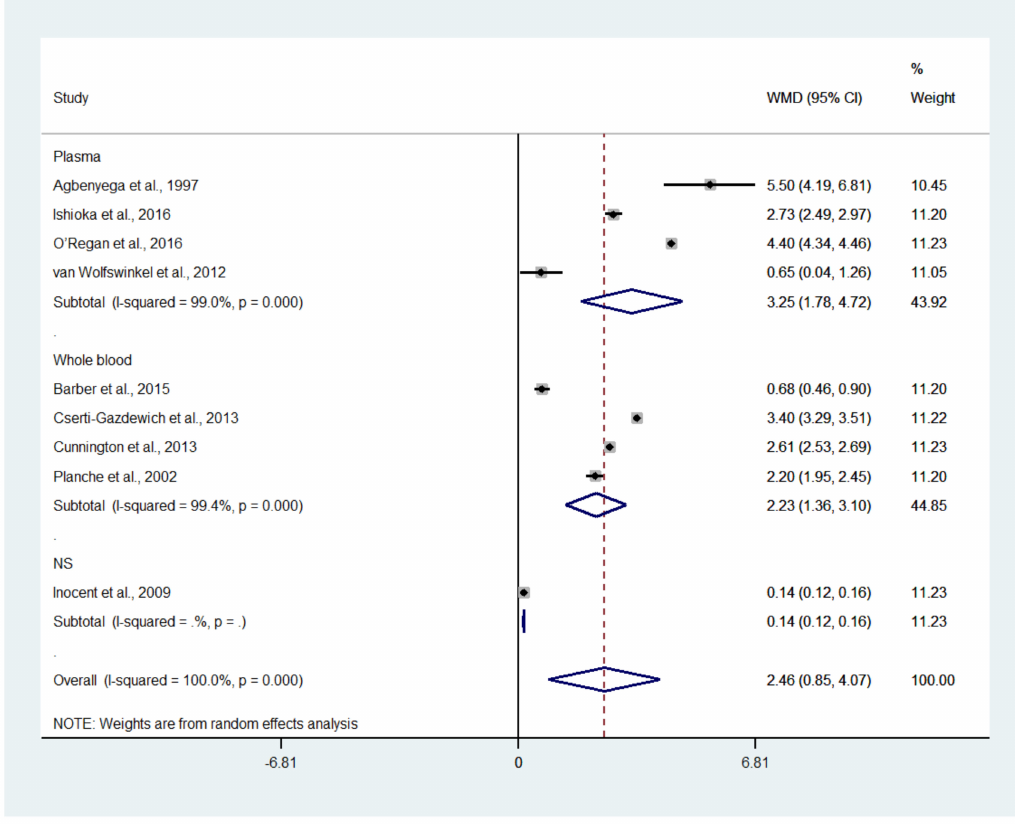
Figure 7. The difference in mean lactate level between patients with severe and uncomplicated malaria according to the different types of blood samples. Abbreviations: WMD, weighted mean difference; CI, confidence